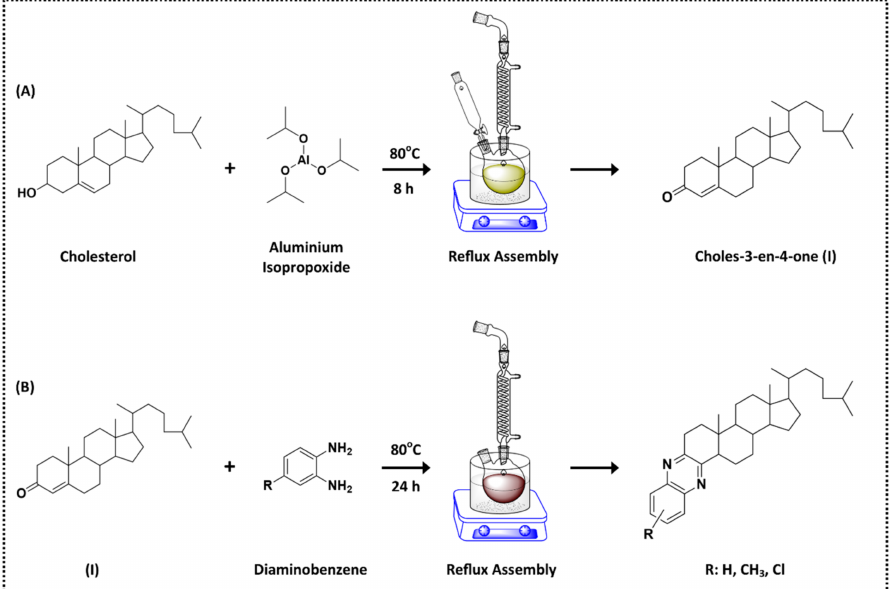
Figure 1. Synthesis of steroidal quinoxalines: ( A ) conversion of cholesterol to cholest-4-en-3-one (I) by Oppenauer oxidation, ( B ) condensation of diaminobenzene, 4-methyl-1,2-diaminobenzene, and 4-chloro-1,2-diaminobenzene with cholest-4-en-3-one (I).